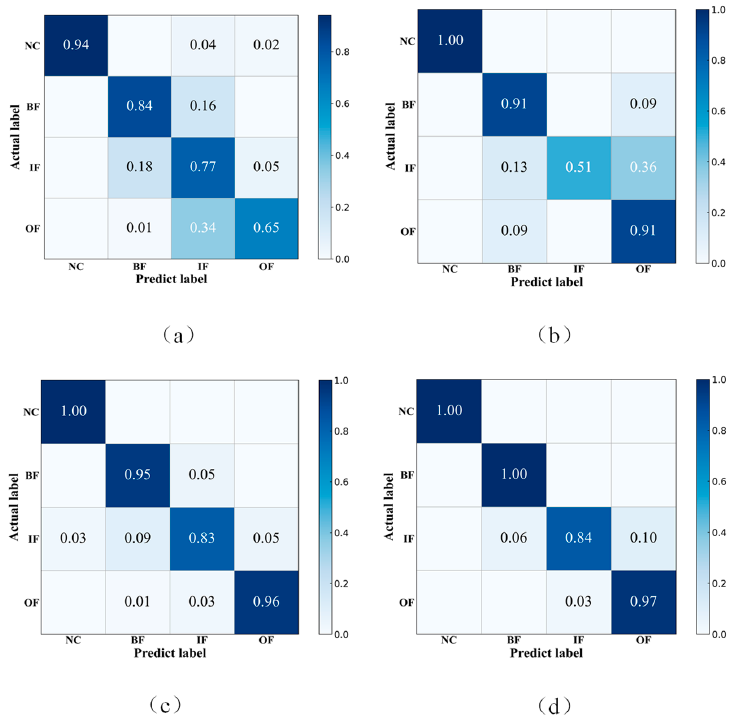
Figure 14. The confusion matrix of fault diagnosis results under different methods. ( a – d ) correspond to the VGGNet, Conv5, ProtoNet-10 shot, and our method-10 shot.